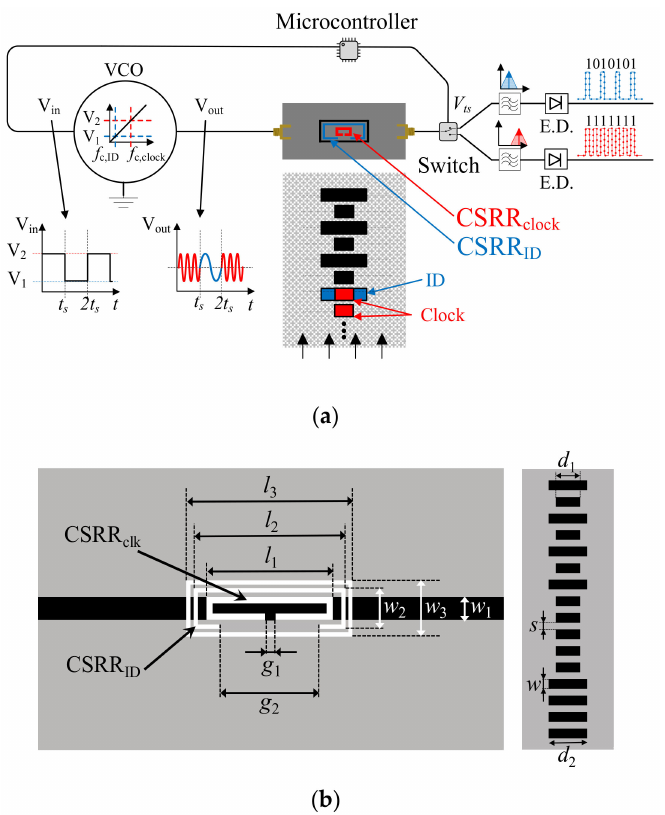
Figure 20. Sketch of the quasi-absolute encoder based on a single chain of metallic patches ( a ) and layout of the reader and encoder (including relevant dimensions) ( b ). Relevant reader dimensions are l 1 = 10.3 mm; l 2 = 12.3 mm, l 3 = 13.5 mm, w 1 = 1.9 mm, w 2 = 3.1 mm, w 3 = 4.3 mm, g 1 = 1.0 mm, g 2 = 7.2 mm. CSRR slots width are c 1 = 0.5 mm and c 2 = 0.3 mm for the inner and the outer CSRR, respectively, and the outer slot ring width is c = 0.3 mm. Encoder dimensions are d 1 = 9.3 mm; d 2 = 14.5 mm, s = 3 mm and w = 3 mm. Reprinted with permission from [26]. Copyright 2020